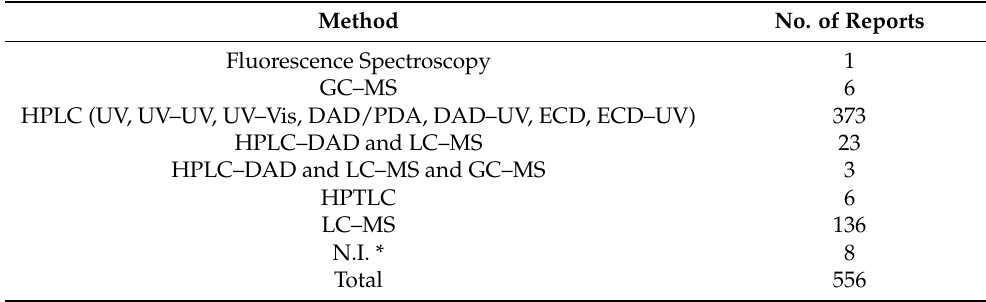
Table 17. Analytical methods used in phenolic compound analysis for monofloral honeys. Method No. of